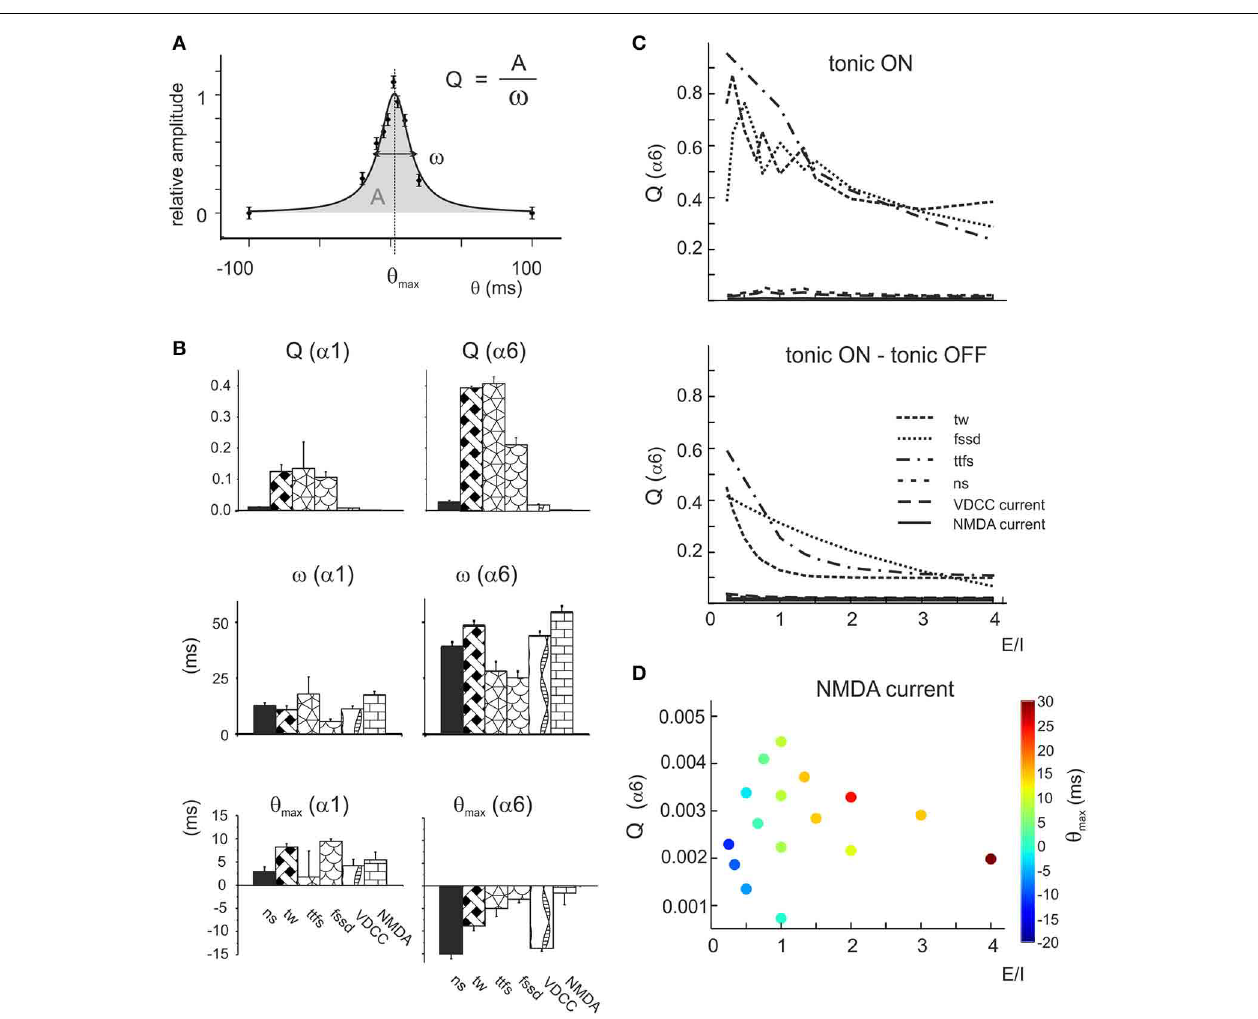
averaged over the whole parameter response space. (C) The top panel shows the Q factorsofthe α 6 OFF differencephase-lagcurves( α 6 OFF -CTRL).Notethat Q oftimewindow( tw ),timetofirstspike( ttfs )andfirstspikestandarddeviation ( fssd ) decrease with increasing E/I , while the other parameters are much less affected.Theb ottom panelshowsthedifference Q factorsobtainedas Q (tonic OFF)– Q (tonic ON). Note that the trends of these Q plots is qualitatively similar to that reported above. (D) Precession of θ max ( α 6) for the NMDA Q factor. The phase of the peak (color coded) increases with increasing E/I